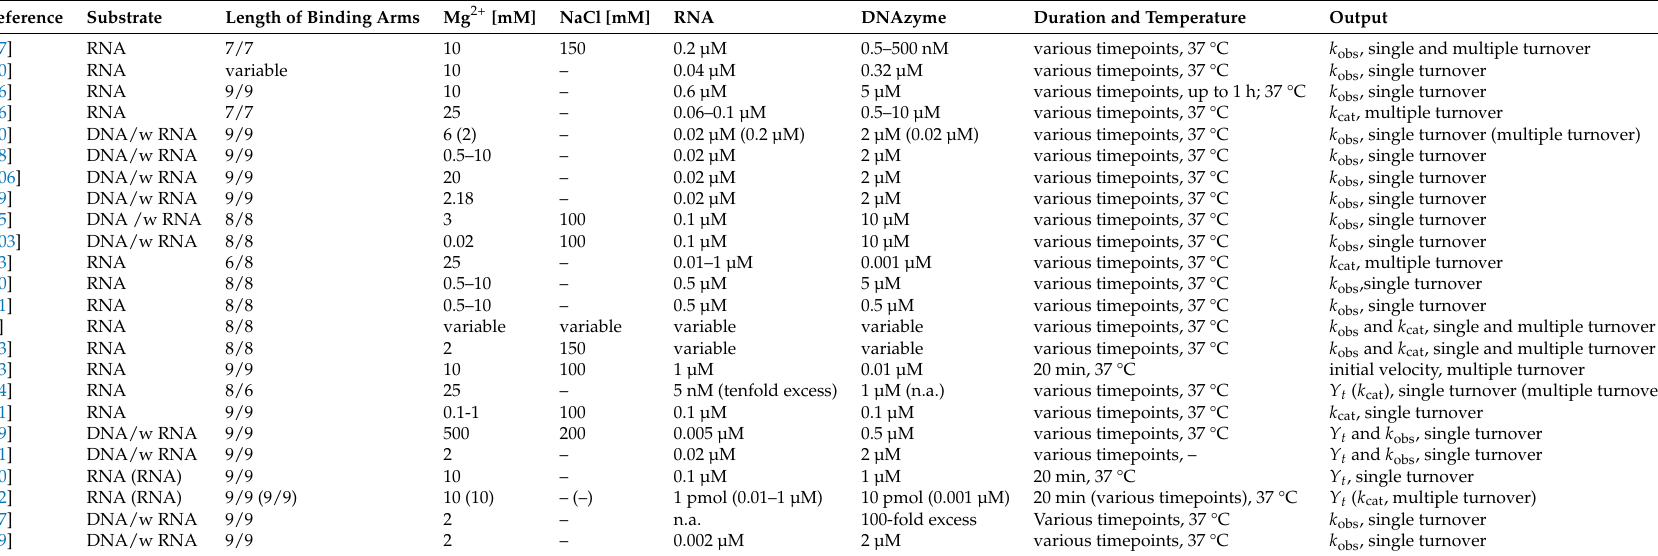
Table 3. Conditions used in selected important kinetic studies on the 10-23 DNAzyme with short substrates in